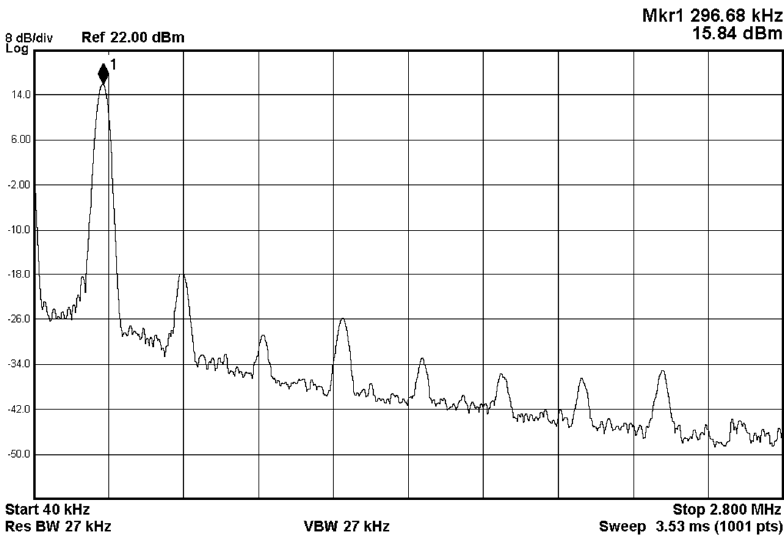
Figure 20. The experimental frequency spectrum of V o 1 . Appl. Sci. 2016 , 6 , 179